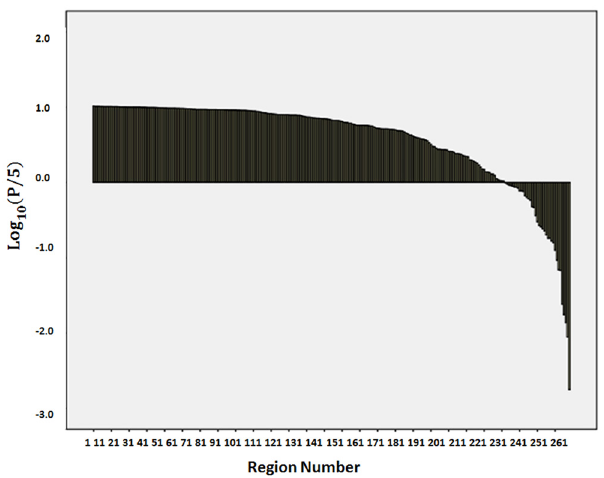
Fig 2. Distribution of Bonferroni-corrected p-values for protocol differences in 286 structures at Level 5. For better visualization, the p-values (P, y-axis) are presented as Log 10 (P/5). A p-value of 0.05 corresponds to -2 on the y-axis. At this threshold, two regions reached statistical